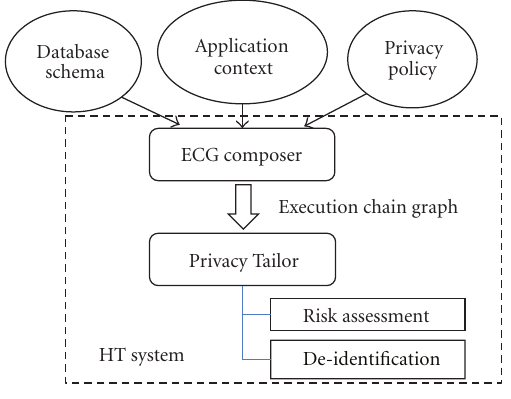
Figure 1: HT system